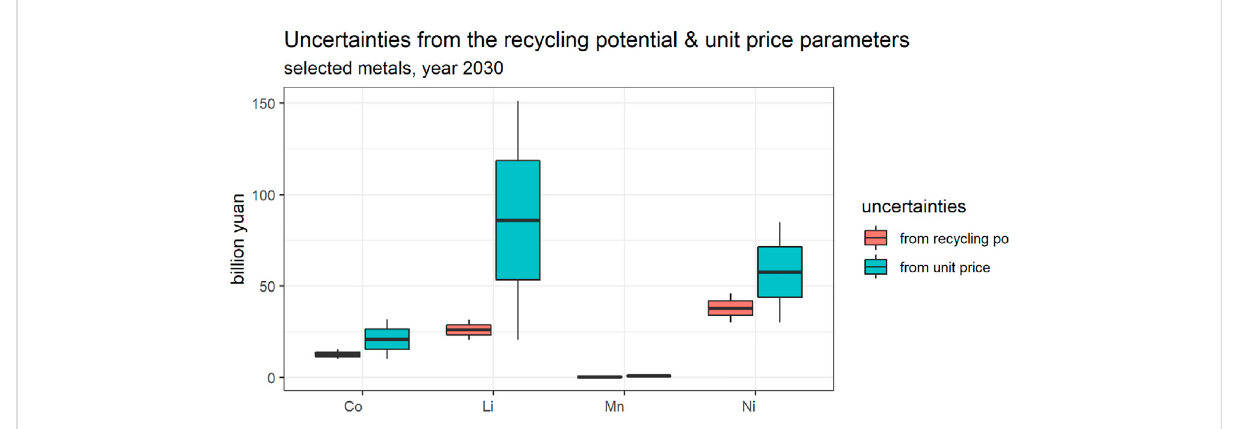
FIGURE 9 Uncertainties from the recycling potential parameters and from unit price